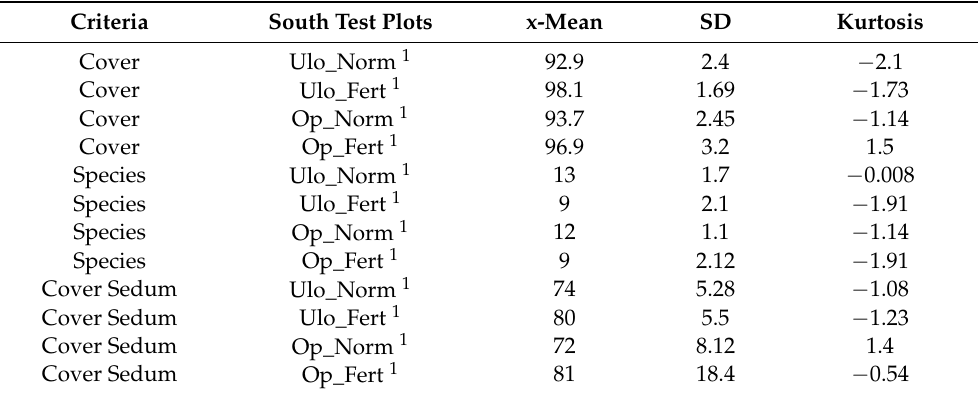
Table 16. Greening with vegetation mats, n = 9 years, from 2011 to 2020. Coverage and number of species, and the coverage of sedum only for the test plots with fertilizer (Fert.) and without (Norm.) for the southern position; mean value, standard deviation, and